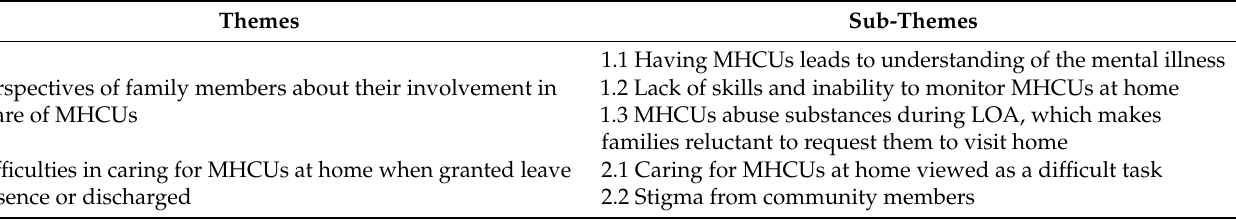
Table 2. Themes and sub-themes emerging from